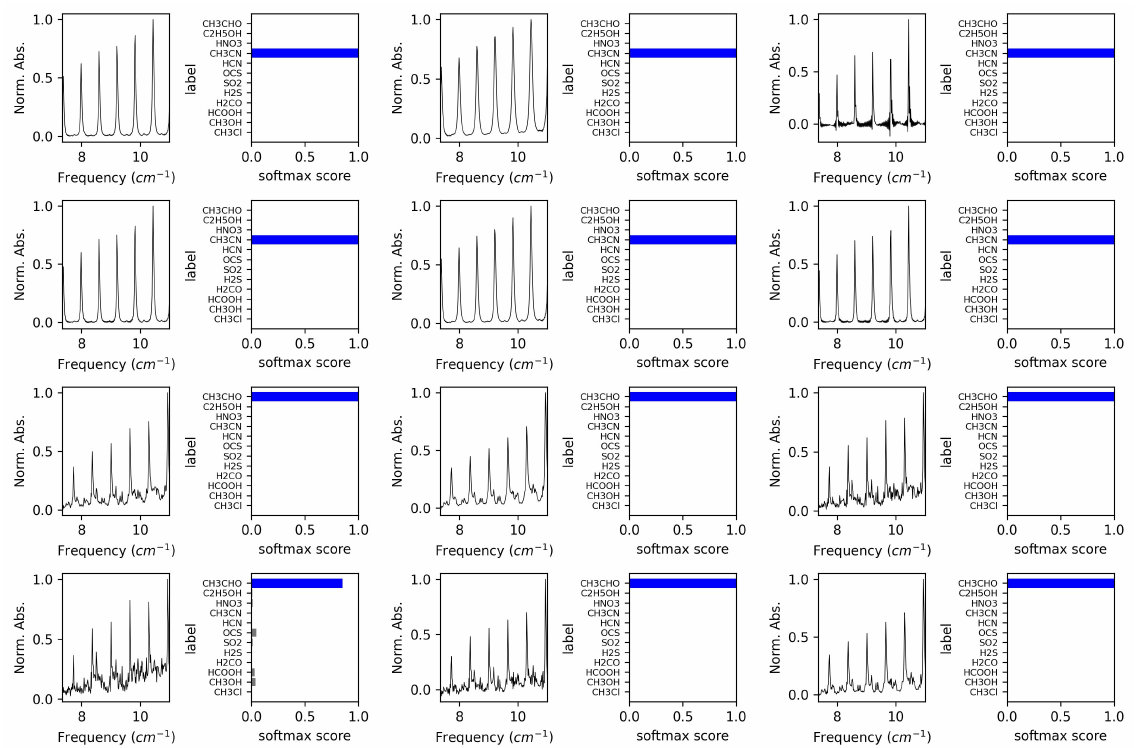
Figure 14. VOC-Net classification of experimental spectra (25–36). The corresponding softmax scores for each classification are given with each spectra.